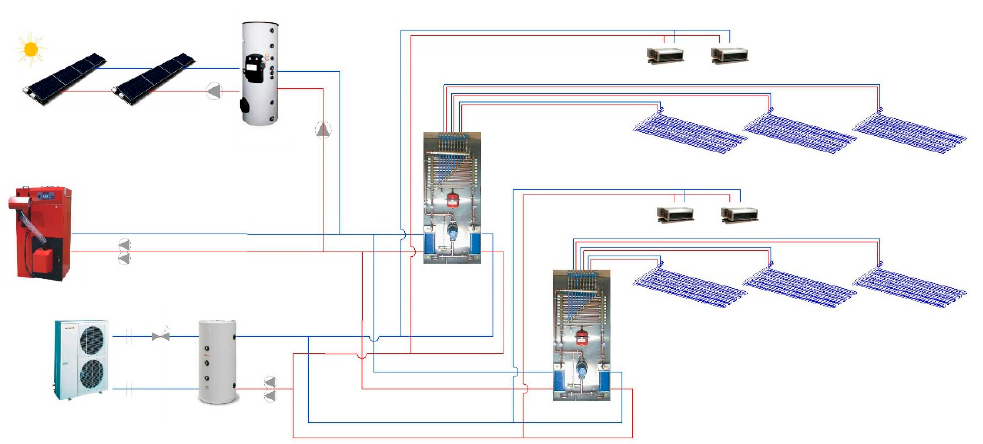
Figure 1. Schematic diagram of a capillary mat installation, with fan-coils for dehumidification, and control substations.